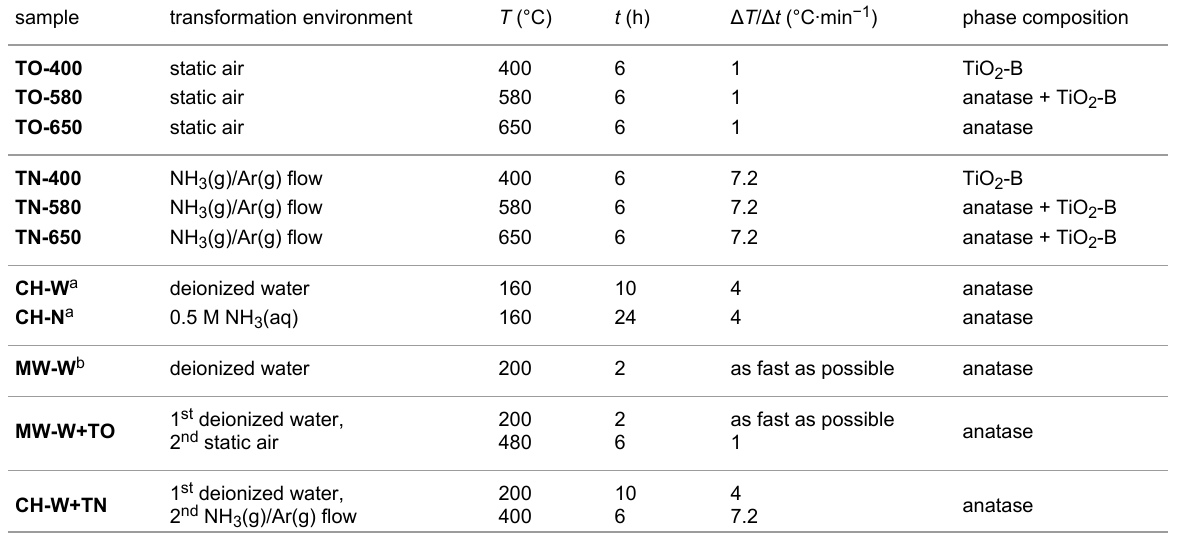
Table 1: Experimental conditions (reaction temperature ( T ), reaction time ( t ) and heating rate ( Δ T / Δ t )) for the transformation of hydrogen titanate nanoribbons to TiO 2 nanoribbons in different environments and the phase composition of the samples.